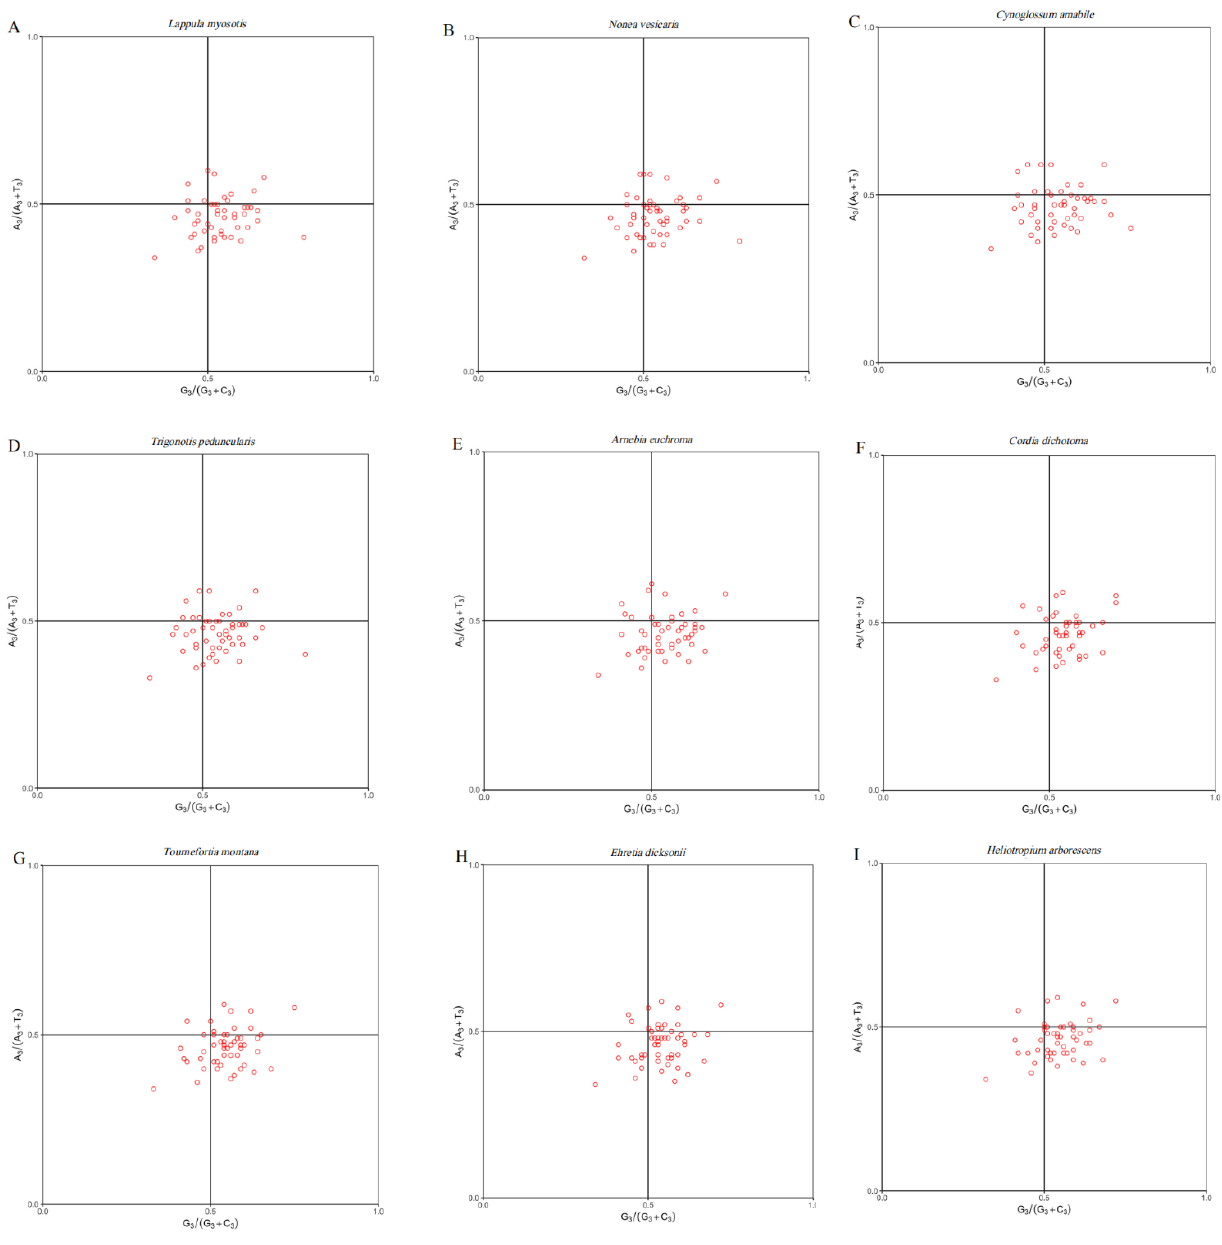
Figure 5. The PR2-bias plots of nine